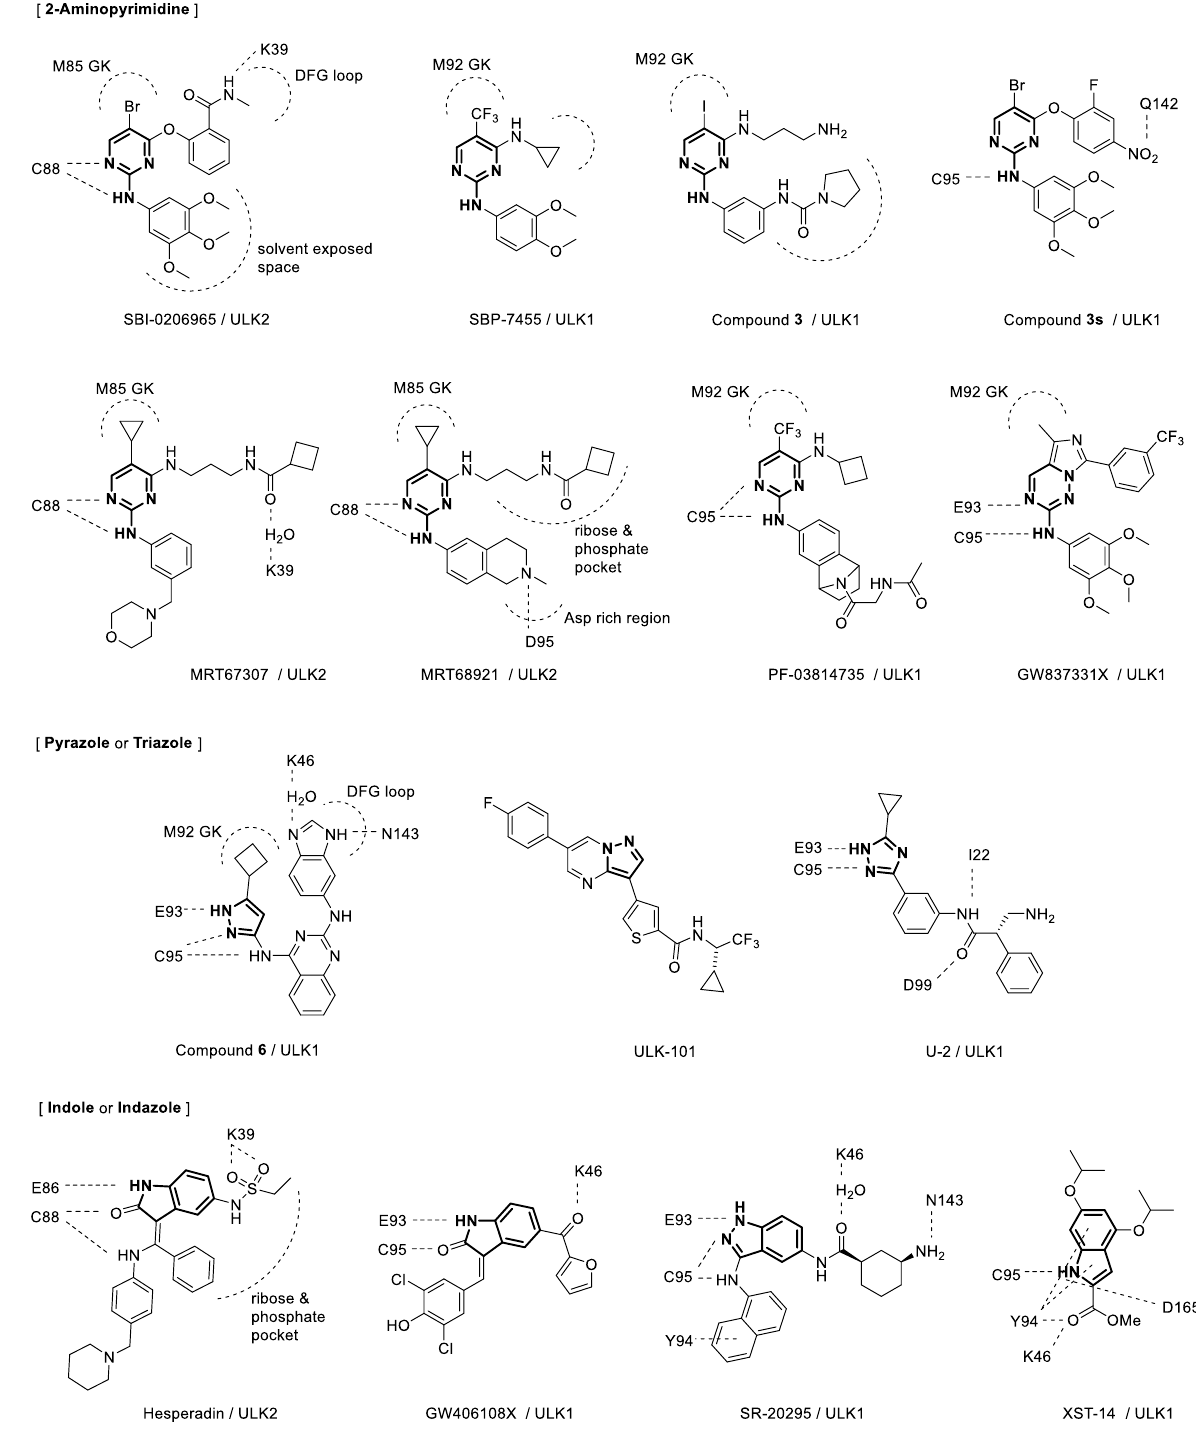
Figure 3. Structures of ULK1/2 inhibitors and key interactions with their binding sites. GK = gate keeper.